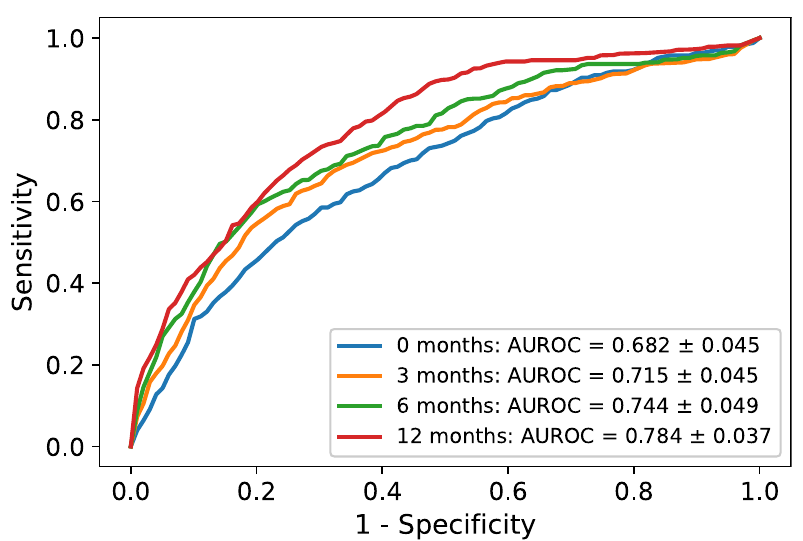
Fig 5. Receiver operating characteristics curves (ROC) to predict revision ESS. We used the logistic regression classifier in the four models, which used four different data collection time periods. The data collection time periods (0, 3, 6 or 12 months) indicate the times during which data were collected after baseline ESS. ESS, endoscopic sinus surgery.